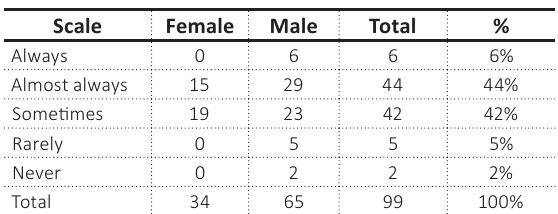
Table 2. Environmental conservation